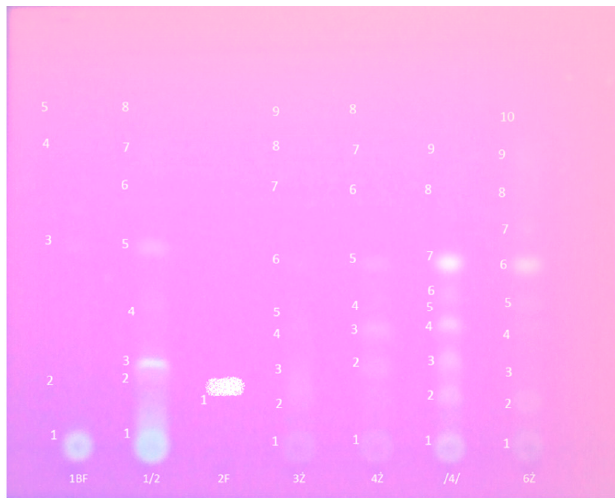
Figure 4. The chromatogram of the 1–6 fractions after preparative thin layer chromatography. Table 2. TLC bands of the hexane layer during preparative thin-layer chromatography (Fertigplatten Gel (Merck, Darmstadt, Germany), toluene/ethyl acetate (3:1, v / v ), reagent W1). TLC